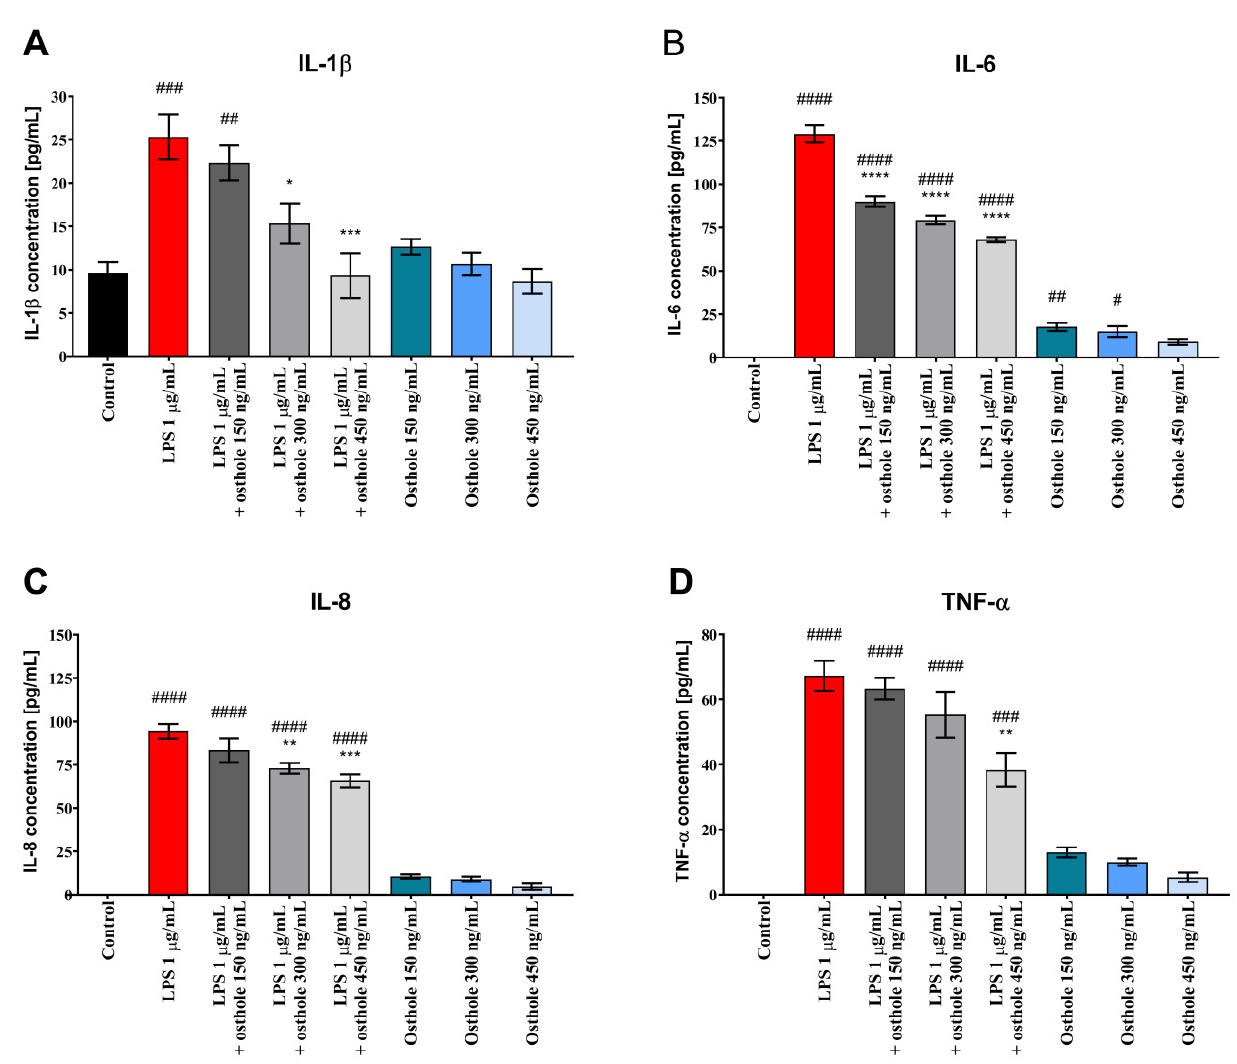
Figure 4. The level of IL-1 β ( A ), IL-6 ( B ), IL-8 ( C ) and TNF- α ( D ) in Caco-2/macrophages co-culture after incubation with LPS (1 µ g/mL), osthole (150–450 ng/mL) and its mixtures. Horizontal line shows mean and bars depict standard error of mean. Statistically significant differences in comparison to control (#— p < 0.05, ##— p < 0.01, ###— p < 0.001, ####— p < 0.0001) and to cells treated with LPS (*— p < 0.05, **— p < 0.01, ***— p < 0.001, ****— p < 0.0001) are marked.